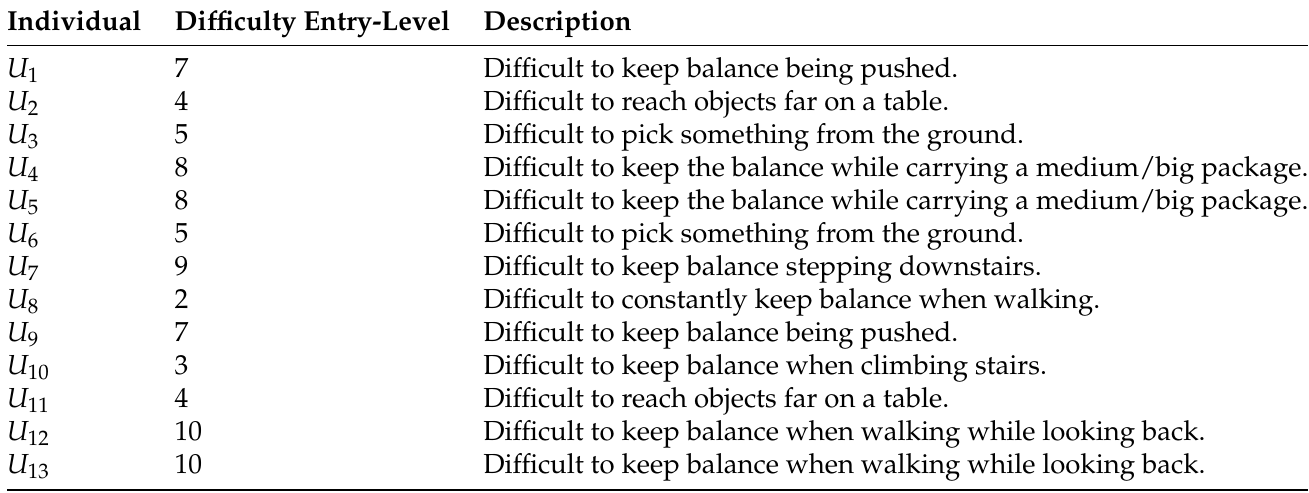
Table 2. Difficulty entry level per individual.